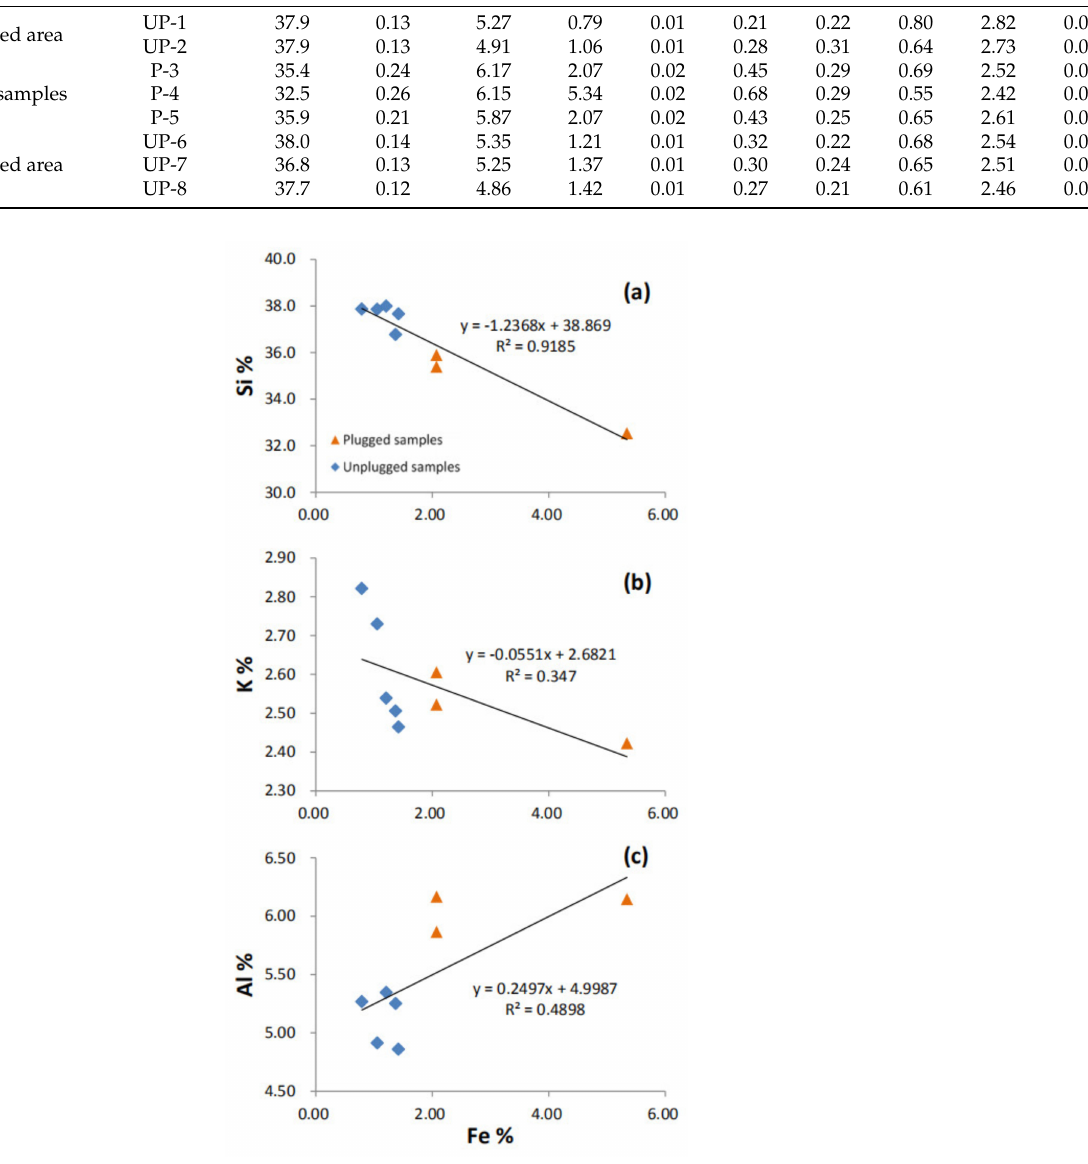
Figure 2. Correlations between the contents of Si, K and Al, and Fe in studied samples: ( a ) negative correlation between Si and Fe; ( b ) negative correlation between K and Fe; ( c ) positive correlation between Al and